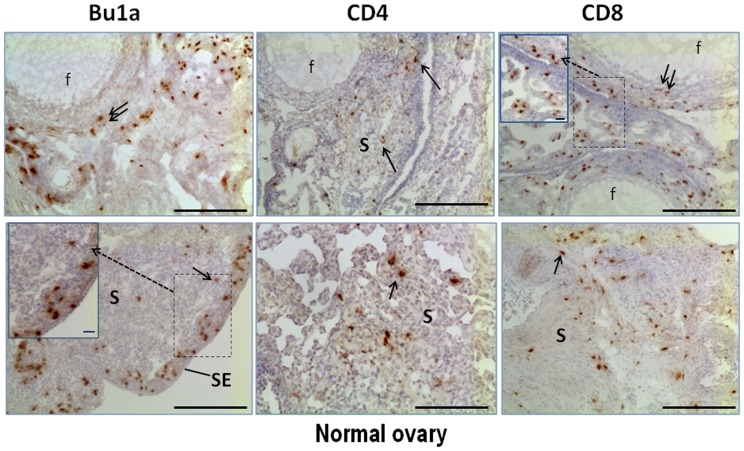
Localization of immune cells in normal hen ovaries.Bu1a+, CD4+ and CD8+ cells (arrows) detected by immunohistochemistry in normal ovaries in the ovarian stroma (S), adjacent to follicles (f), in the thecal layer of follicles (double arrow) and were abundant in the cell layer under the ovarian surface epithelium (SE). Original magnification, 10x; scale bar = 100 µm. Selected areas (dotted boxes) are shown in an inset at higher magnification for Bu1a and CD8 staining; inset scale bars = 10 µm.